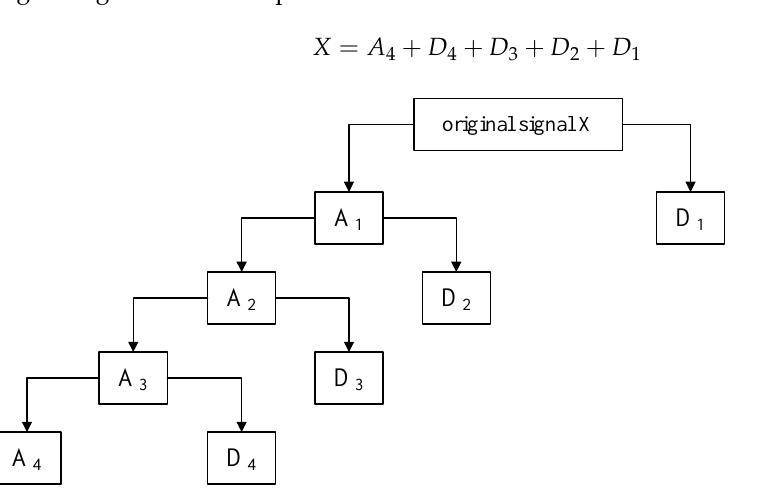
Figure 2. The DWT decomposition schematic. Ai indicates the i th layer approximate signal, D i indicates the i th layer detailed signal.